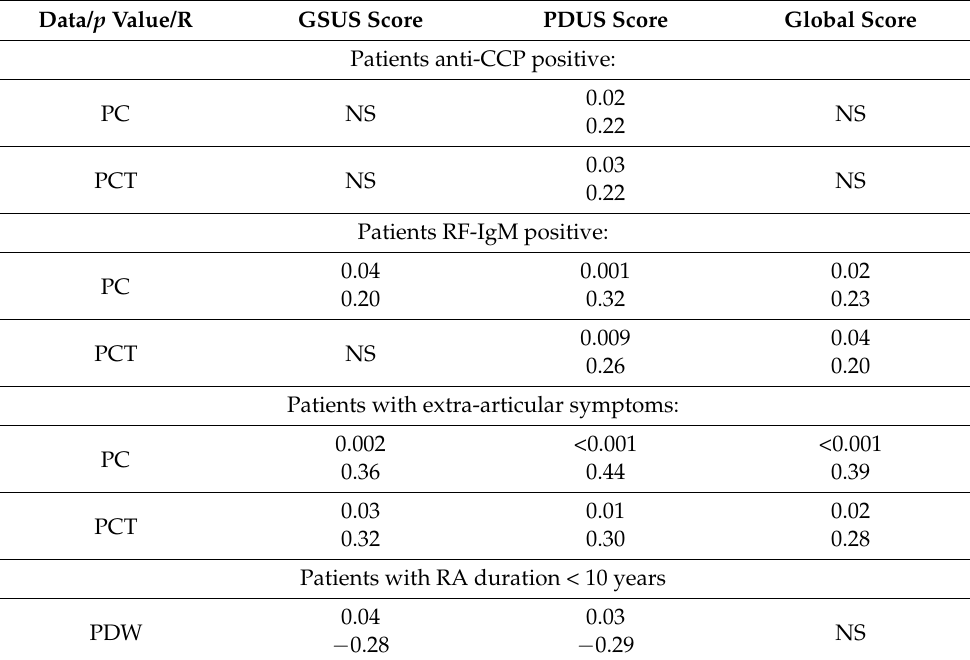
Table 4. Significant correlations between PIs and US parameters in certain groups of patients with RA.